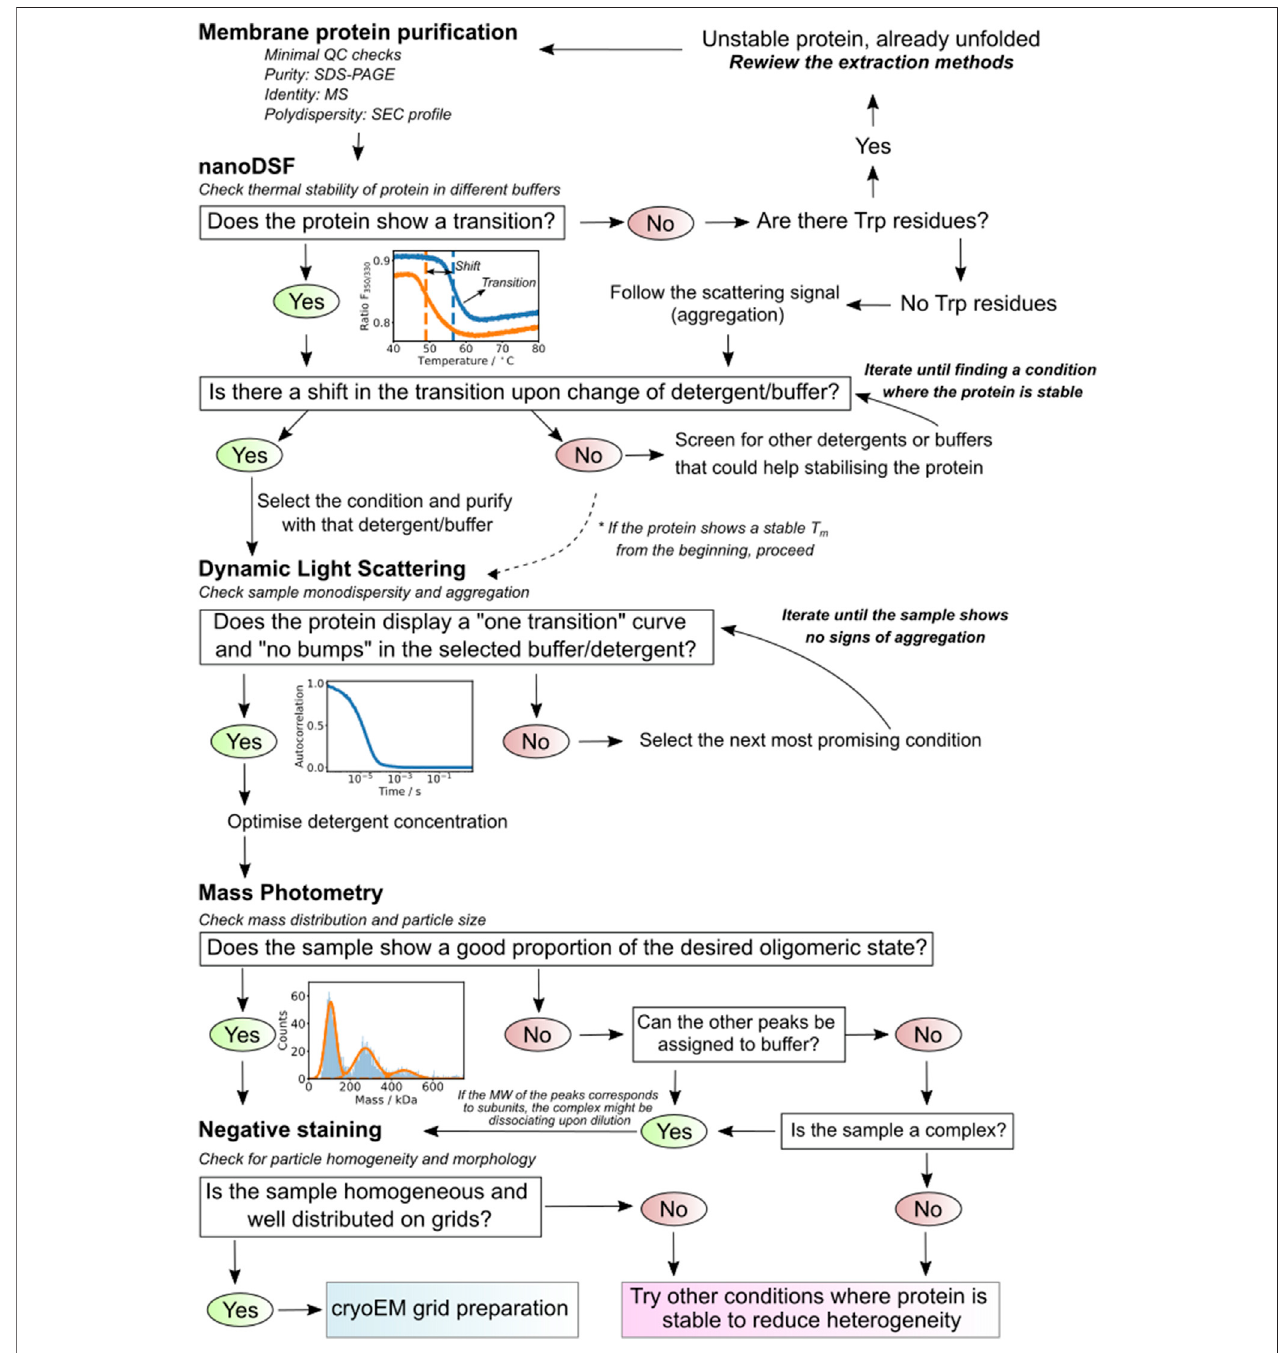
FIGURE 9 | Summary diagram. The scheme presents a de fi ned decision-making strategy based on the results of each of the used techniques. It guides the researcher on how to proceed depending on the results of the steps previously applied.